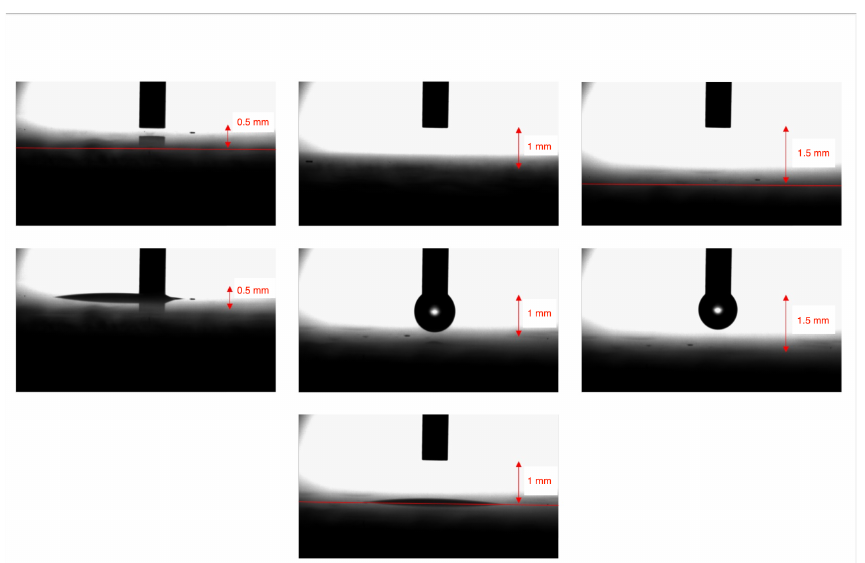
Figure 7. Droplet deposition outcomes for different syringe-platform spacings. Left column: spacing too low. Middle column: spacing too large, dispensing velocity too large (splashing or rebound of droplet upon contact with substrate). Right column: spacing too large and dispensing velocity too small (no